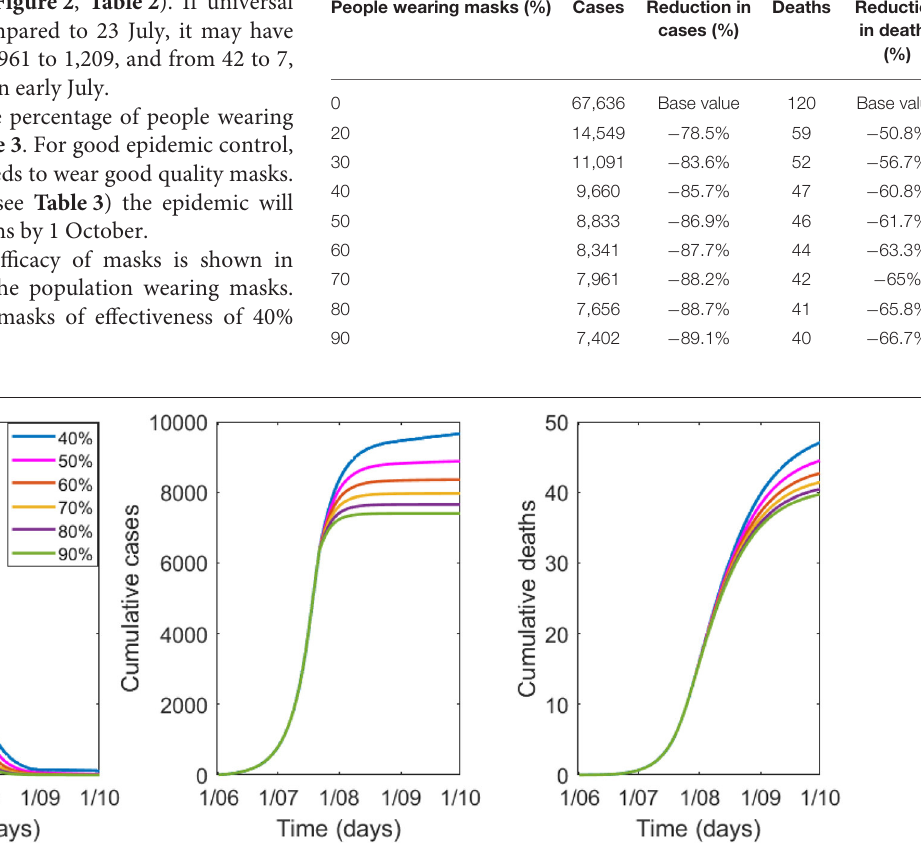
Frontiers in Public Health |